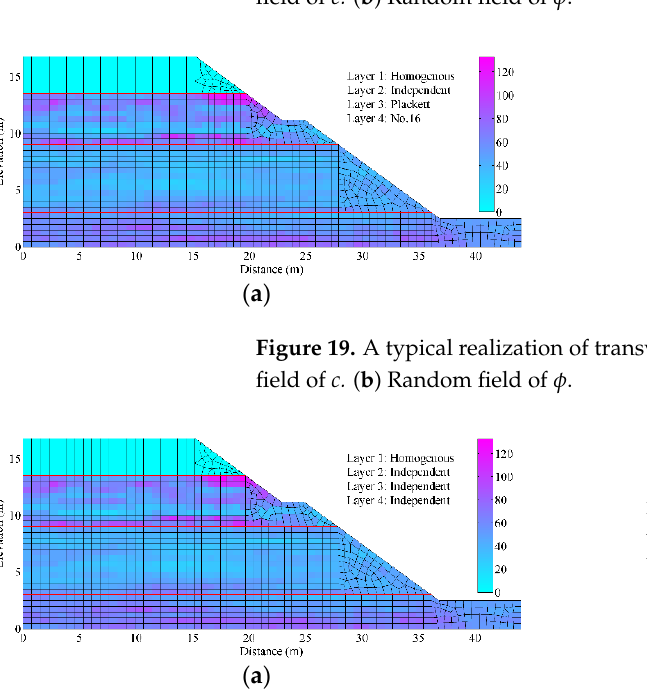
( b ) Figure 22. A typical realization of transversely anisotropic CCRF yielded by strategy 6. ( a ) Random field of c. ( b ) Random field of ϕ.